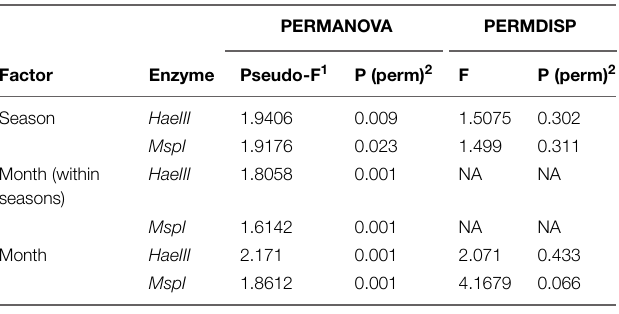
TABLE 1 | Permutational statistical (PERMANOVA) and dispersion (PERMDISP) analyses of T-RFLP data to assess the bacterial community structure in D. fulgens over time.